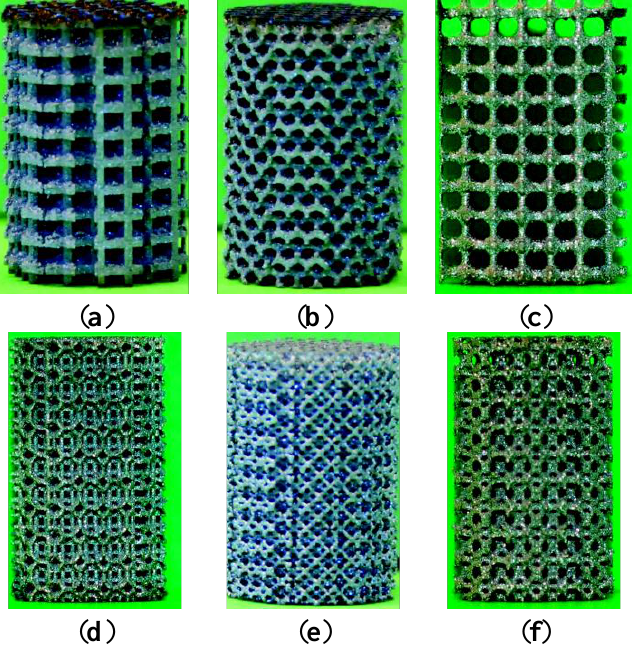
Figure 2. Sample specimens from the porous structures based on different types of unit cells: ( a ) Cubic; ( b ) Diamond; ( c ) Truncated cube; ( d ) Truncated cuboctahedron; ( e ) Rhombic dodecahedron; ( f )